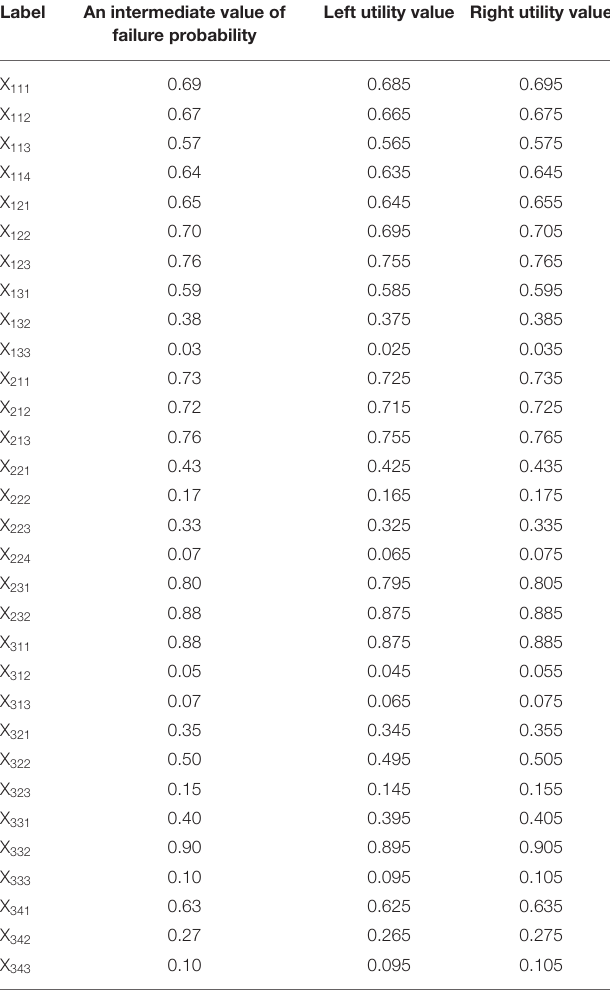
TABLE 1 | Event occurrence probability of classroom teaching failure.